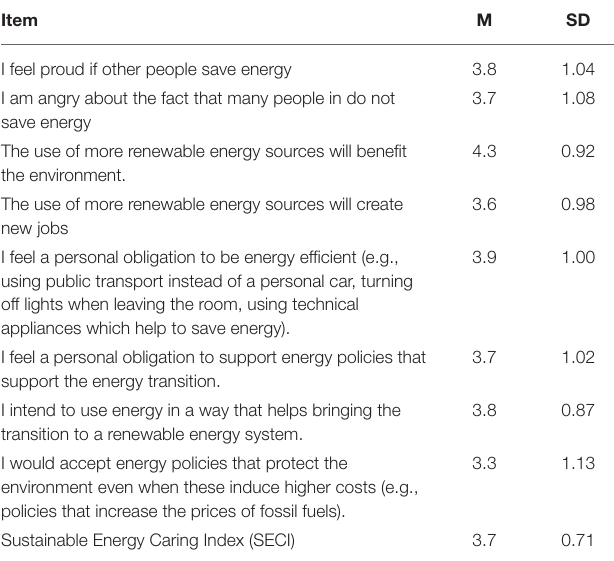
TABLE 3 | Items included in the sustainable energy caring index